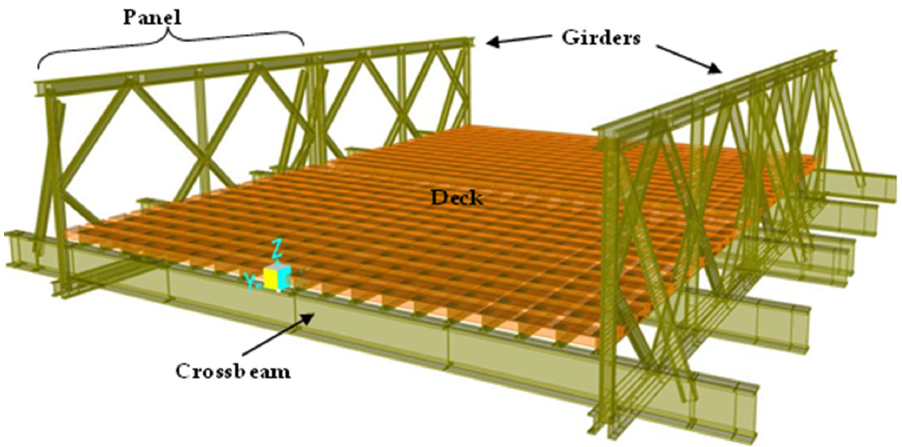
Figure 3. Bailey bridge segment (“bay” in US nomenclature).